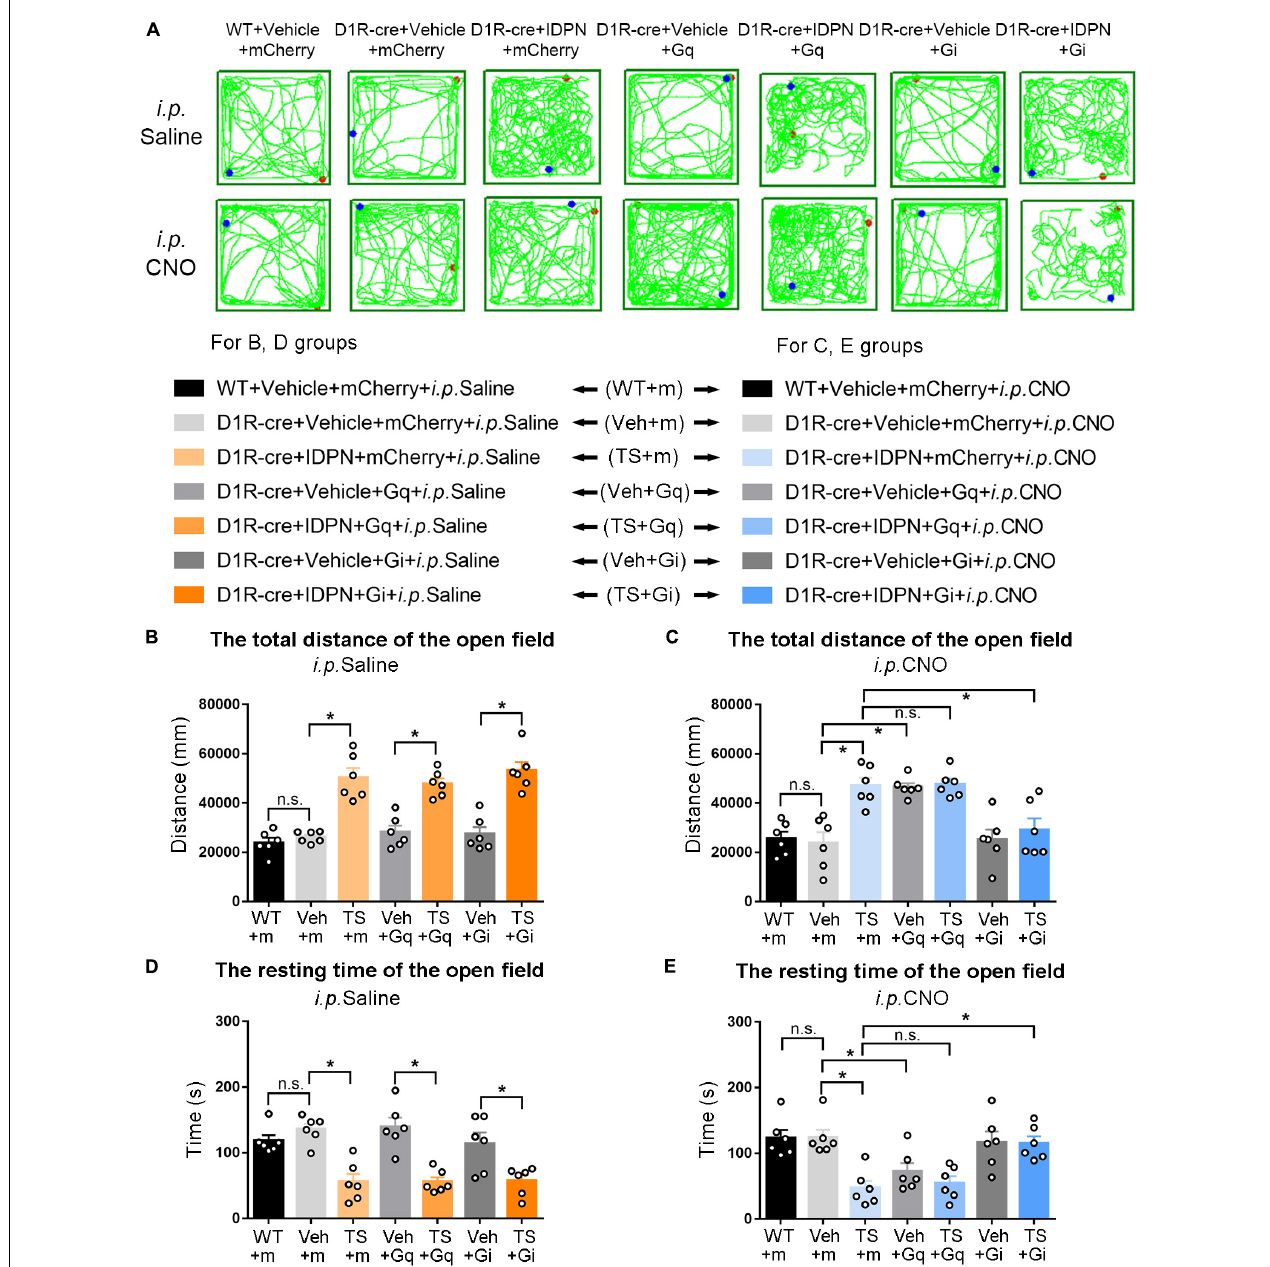
FIGURE 4 | Effects of activation or inhibition of D1R-containing neurons in the dSTR on total distance and resting time in the open-field test in mice. (A) Evaluations of the trajectory in the open-field test in mice 30 min after the injection of saline (i.p. Saline) or CNO (i.p. CNO) in the WT + Vehicle + mCherry + i.p. Saline group (WT + m), D1R-cre + Vehicle + mCherry + i.p. Saline group (Veh + m), D1R-cre + IDPN + mCherry + i.p. Saline group (TS + m), D1R-cre + Vehicle + Gq + i.p. Saline group (Veh + Gq), D1R-cre + IDPN + Gq + i.p. Saline group (TS + Gq), D1R-cre + Vehicle + Gi + i.p. Saline group (Veh + Gi), D1R-cre + IDPN + Gi + i.p. Saline group (TS + Gi), WT + Vehicle + mCherry + i.p. CNO group (WT + m), D1R-cre + Vehicle + mCherry + i.p. CNO group (Veh + m), D1R-cre + IDPN + mCherry + i.p. CNO group (TS + m), D1R-cre + Vehicle + Gq + i.p. CNO group (Veh + Gq), D1R-cre + IDPN + Gq + i.p. CNO group (TS + Gq), D1R-cre + Vehicle + Gi + i.p. CNO group (Veh + Gi), D1R-cre + IDPN + Gi + i.p. CNO group (TS + Gi) on day 23. (B) Total distance in the open-field test within 10 min in mice of each group 30 min after the injection of saline (i.p. Saline) on day 23. (C) Total distance in the open-field test within 10 min in mice of each group 30 min after the injection of CNO (i.p. CNO) on day 23. (D) Resting time in the open-field test within 10 min in mice of each group 30 min after the injection of saline (i.p. Saline) on day 23. (E) Resting time in the open-field test within 10 min in mice of each group 30 min after the injection of CNO (i.p. CNO) on day 23. Data are expressed as mean ± SEM ( n = 6 mice in each group), and the black line segment indicates the differences between groups, * represents P < 0.05 between marked groups, and n.s. represents P > 0.05 between marked